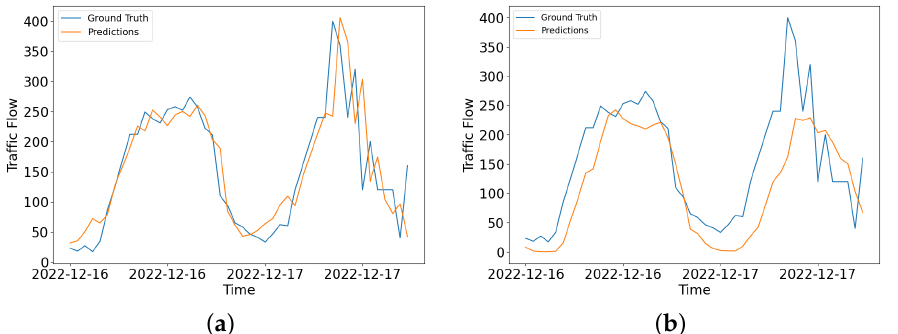
Figure 5. Visualizations of prediction results for the forecasting horizon of 3 h for sensor MS985: ( a ) Temporal Graph Convolutional networks (TGCN), and ( b ) Diffusion Convolutional Recurrent Neural Network